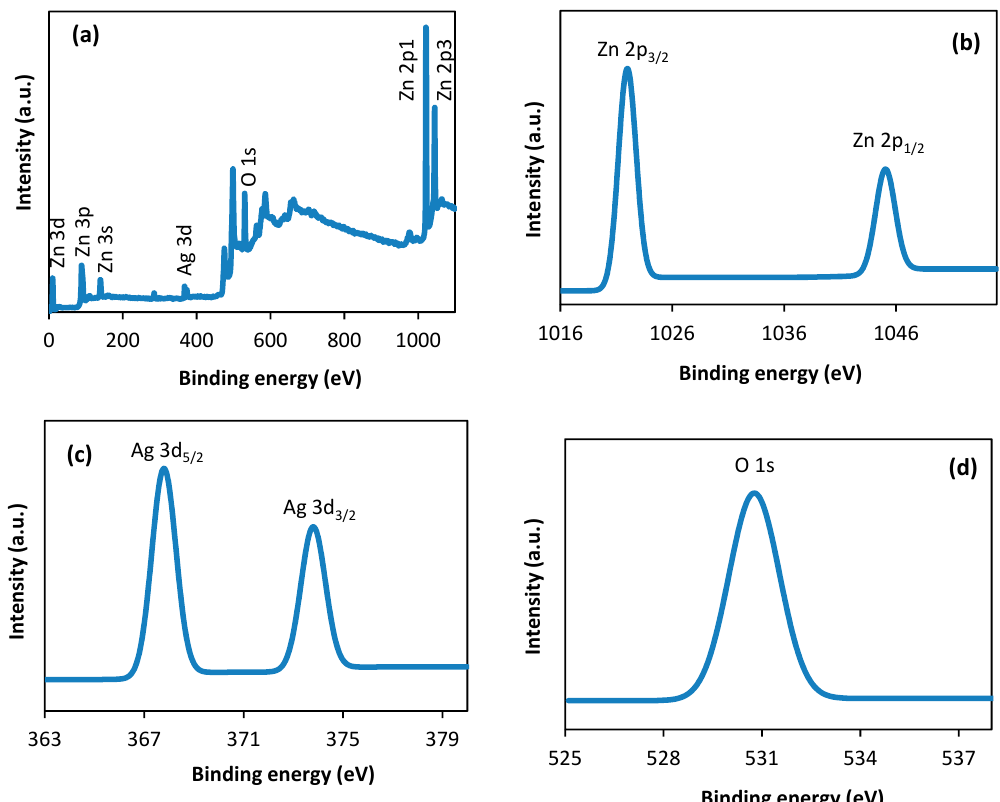
Figure 11. ( a ) Full range XPS spectra of Ag/ZnO; ( b – d ) High resolution XPS spectra of Zn 2P, Ag 3d and O 1s for ZnO.